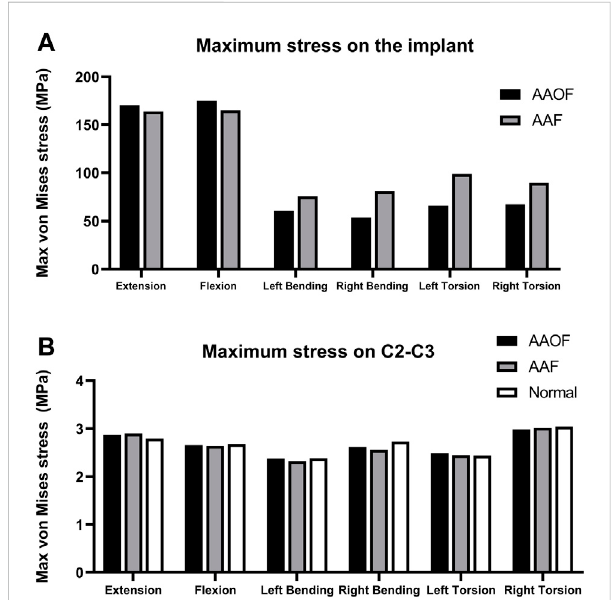
FIGURE 4 Themaximum v onMisesstress(Mpa)ontheimplants (A) andC2- C3 intervertebral discs (B) for AAF and AAOF models. AAOF, anterior axis-atlanto-occipital transarticular fi xation; AAF, anterior atlantoaxial transarticular fi